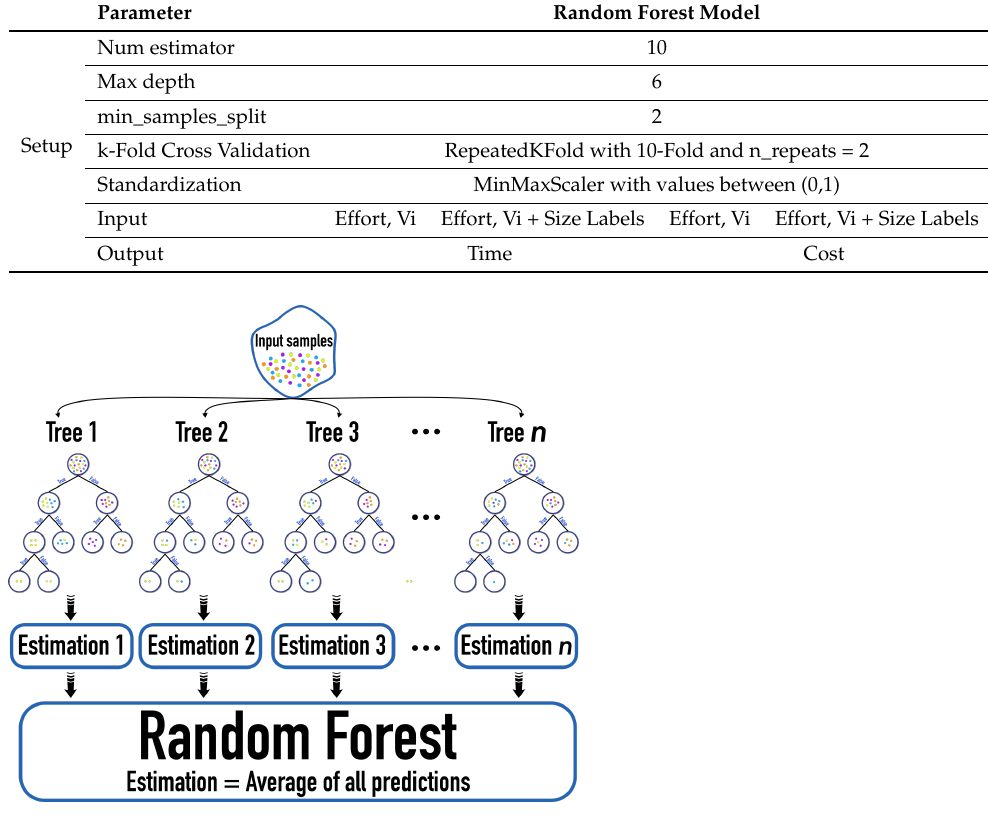
Figure 2. Random forest diagram, each coloured dot represents a single project record from the dataset.